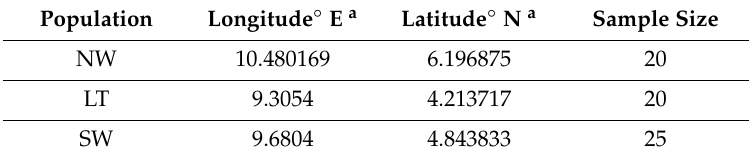
Table 1. Sampled populations of P. africana , geographic location of sampling areas, and sample